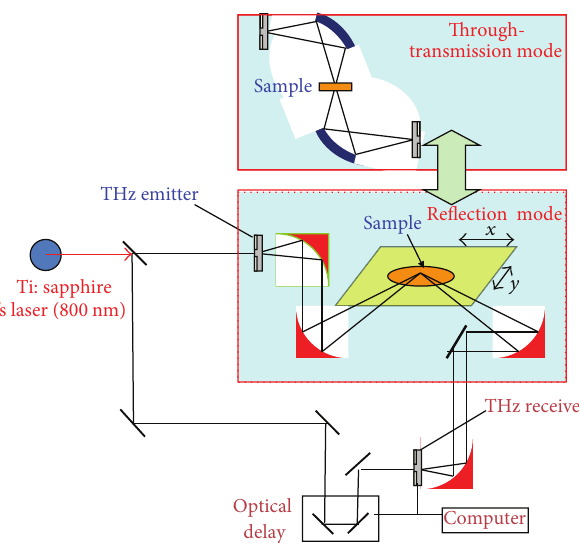
Figure 2: A schematic diagram of a THz-TDS